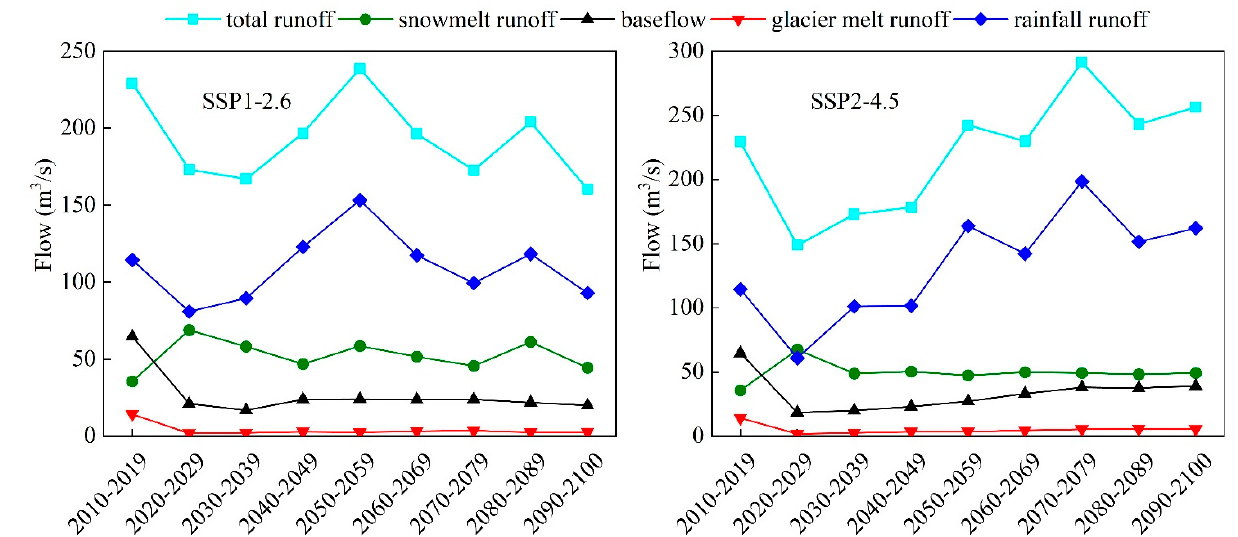
Figure 14. Average flow of various runoff components per decade.